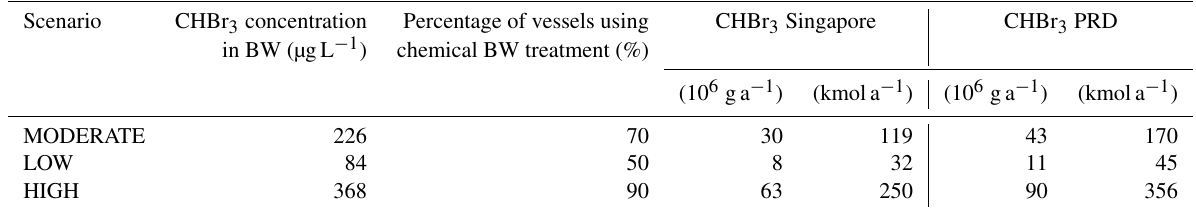
Table 2. Scenarios for the simulation of ballast water (BW) spread with different initial bromoform concentration and annual bromoform amount for two regions in Southeast Asia, Singapore and the Pearl River Delta